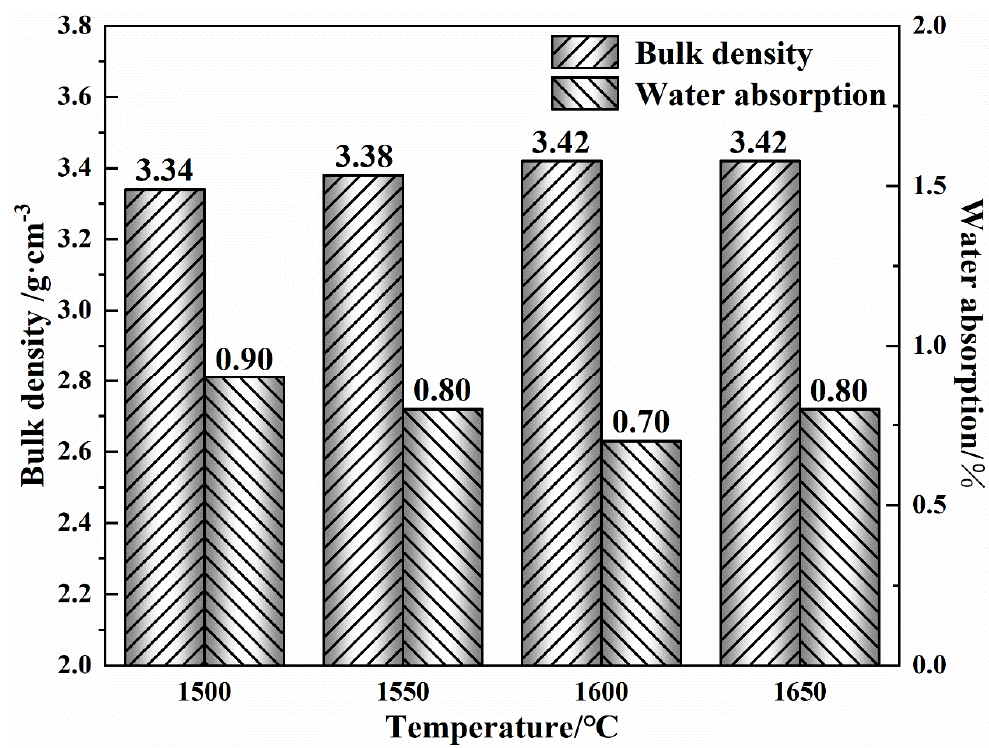
Figure 2. Bulk density and water absorption of the MgO-CaO-Fe 2 O 3 clinker fired at different temperatures.